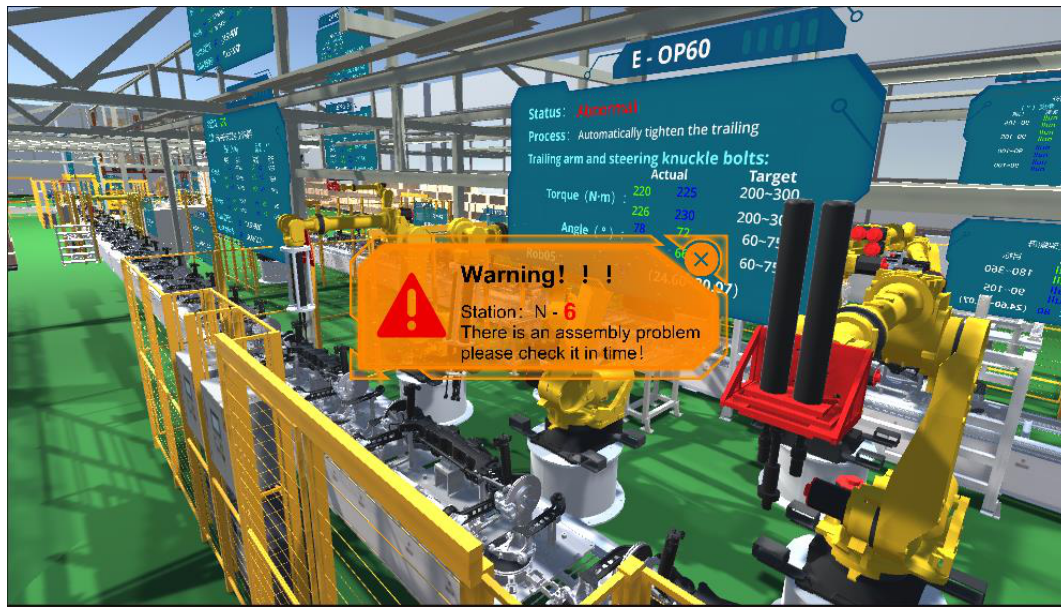
Figure 6. Fault diagnosis system.